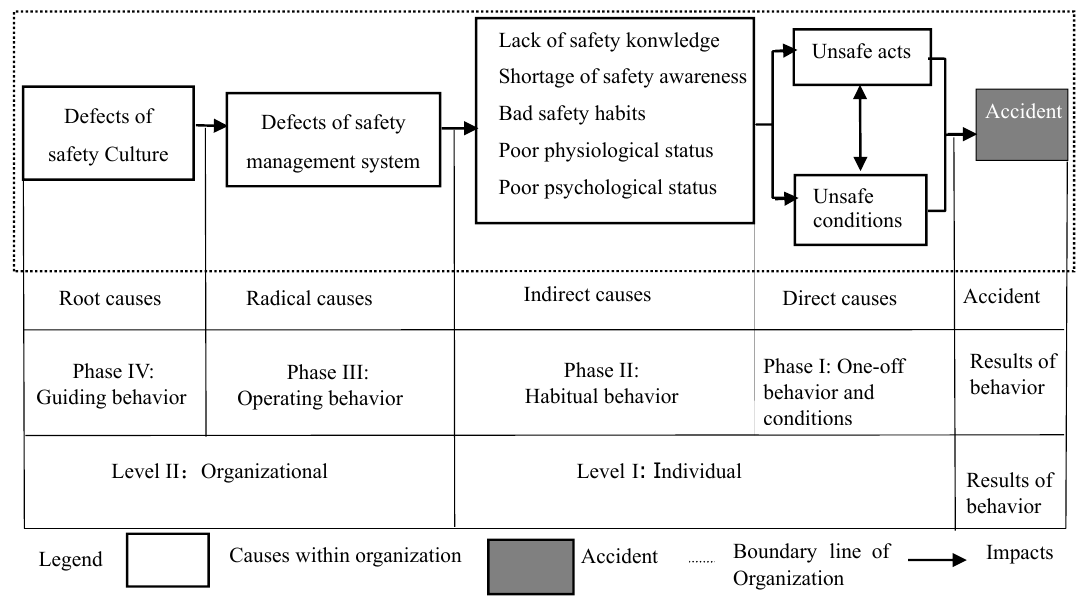
Figure 1. Accident causation “2-4” model (24 Model).